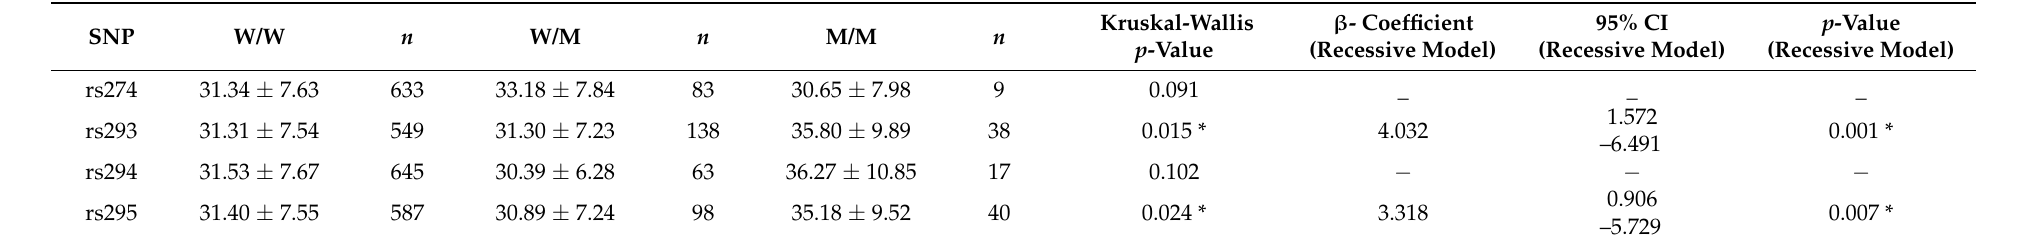
Table 6. A comparison of the mean BMI of the selected LPL genetic variants, followed by a linear regression assessing the association between rs293 and rs295 with BMI under a recessive genetic model adjusting for age and sex in 725 Kuwaiti